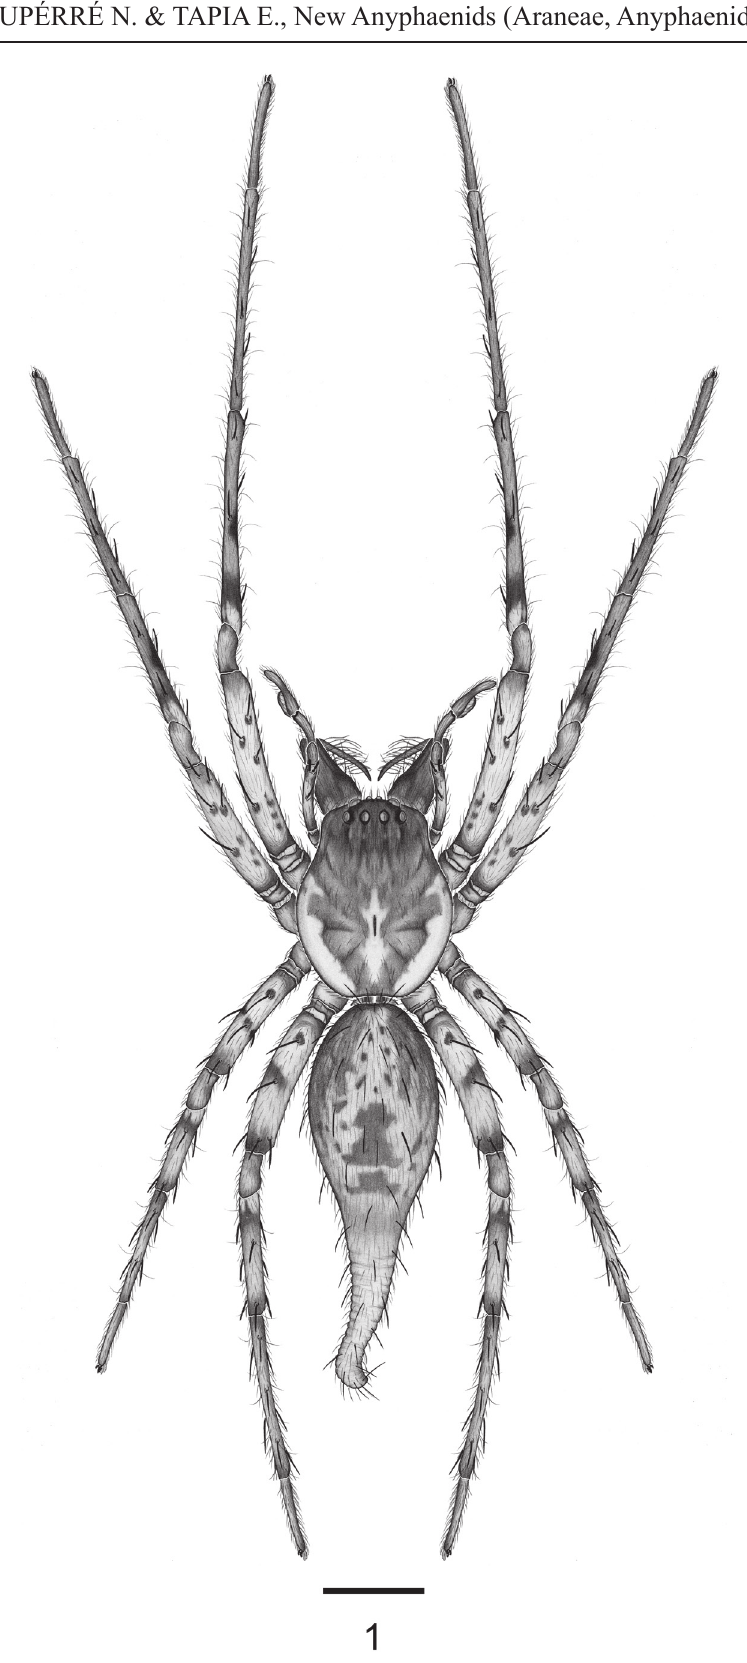
DUPÉRRÉ N. & TAPIA E., New Anyphaenids (Araneae, Anyphaenidae) from